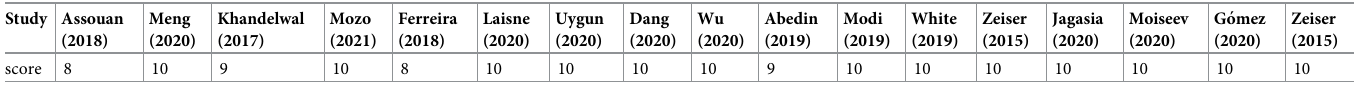
Table 2. MINORS evaluation form for non-randomized clinical trials included in the literature.